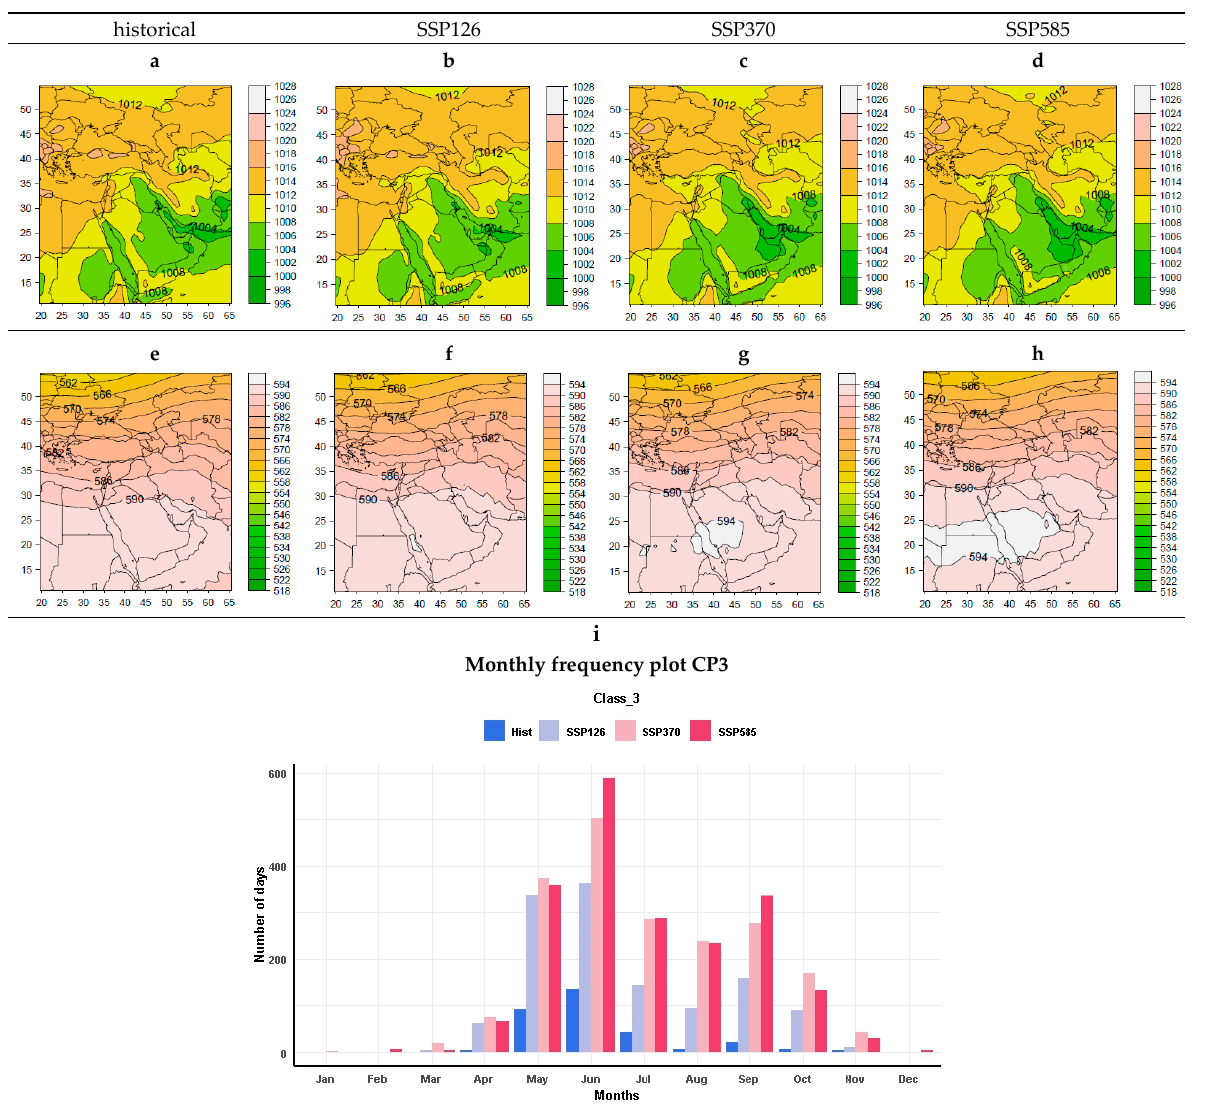
Figure 5. As in Figure 3 for CP3. The Siberian high pressure in CP4 extends from the Caspian Sea to the north of Iran, which can be seen in the projected patterns for the future. Therefore, this high-pressure system affects the northern half of the country. At the 500 hPa level, the trough developed in the northeast of the country, and the ridge extends from Northeast Africa to the west of the Caspian Sea; there is no significant change in future patterns. CP4 also occurs often in the year’s cold season, so its frequency is higher in January, February, March, April, and December. There are no events in June, July, August, and September. The future pro- jection shows a slight increase in frequency in January, March, and April (Figure 6).